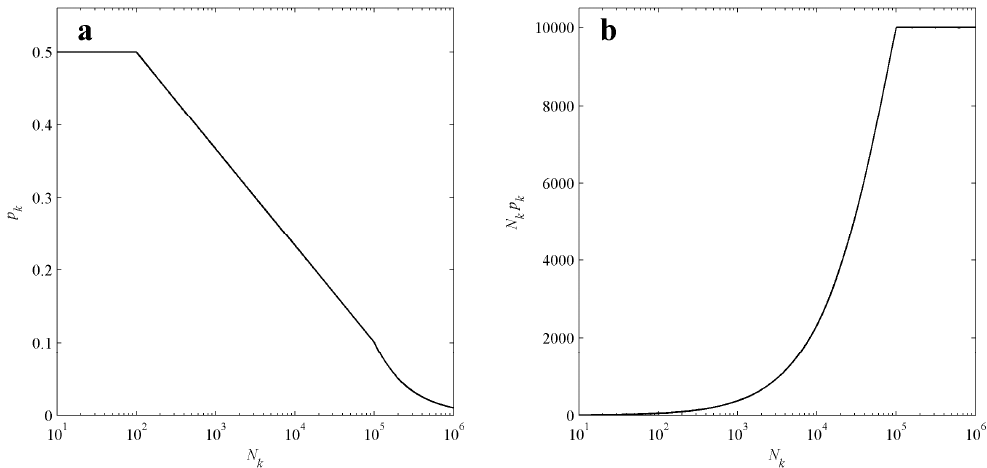
Figure 3. Determination of class-specific thresholding factors. ( a ) The proportion of pixels used as stable sites ( p k ) as a function of the total number of pixels per class ( N k ). ( b ) The total number of pixels used as stable sites ( N k p k ) as a function of the total number of pixels per class ( N k ). Both graphs ( a ) and ( b ) are shown with n max = 10,000 pixels.